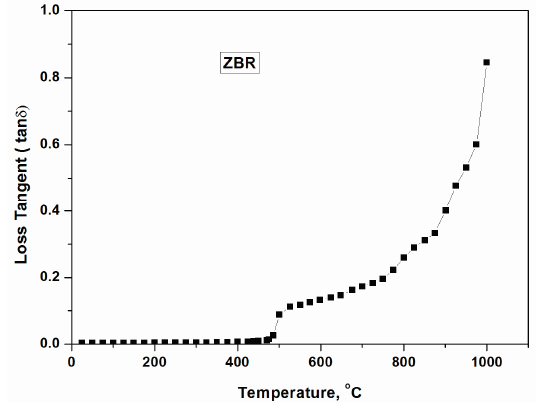
Figure 11. Dielectric loss tangent of ZBR glass until 1000